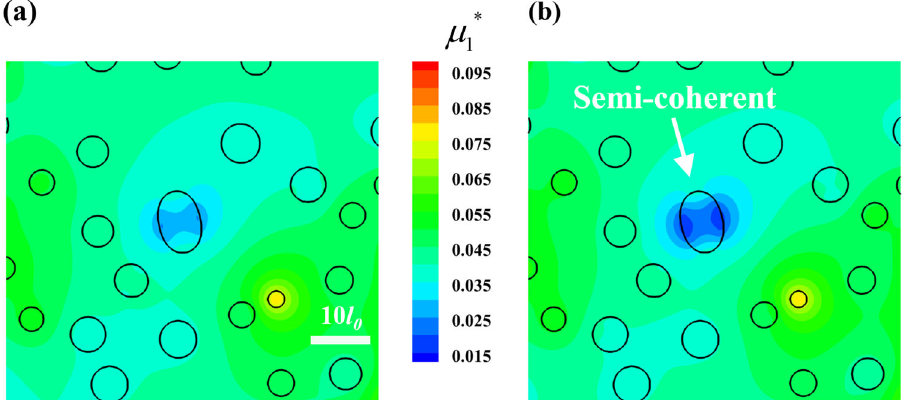
Fig. 7 Simulated distribution of normalized chemical potential of scandium ( μ (cid:1) particles), and b t = 1850 t 0 , with loss of coherency of one particle (marked by the white